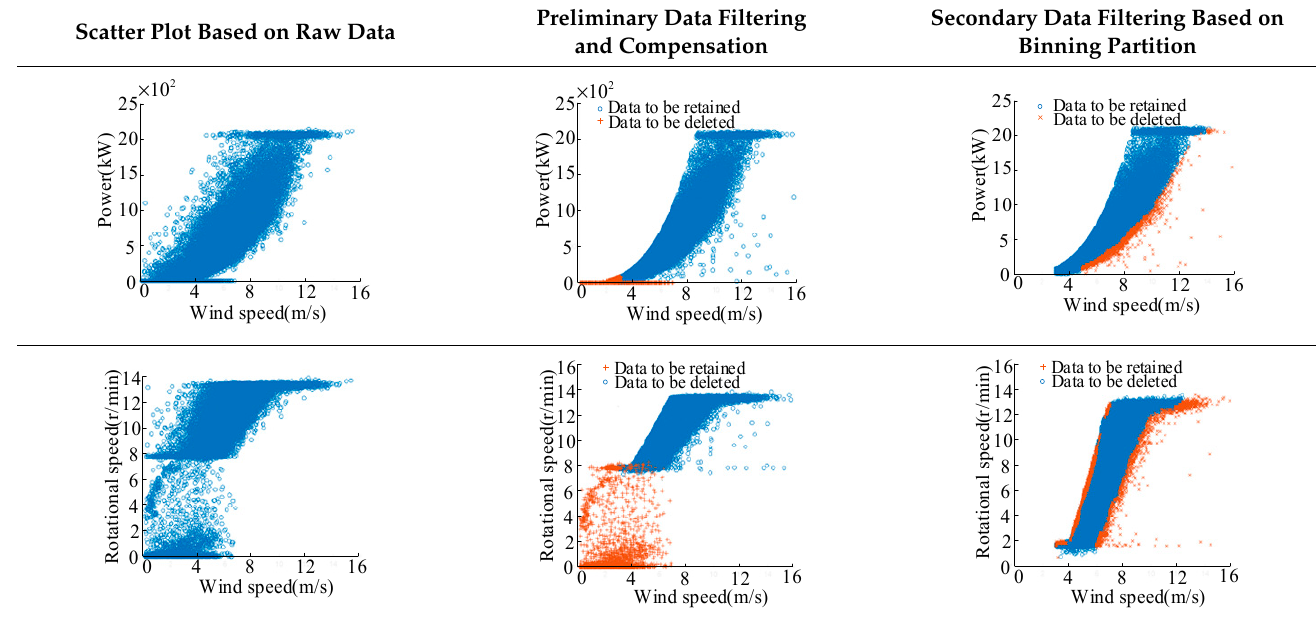
Table 2. Data pre-processing methods. Scatter Plot Based on Raw Data